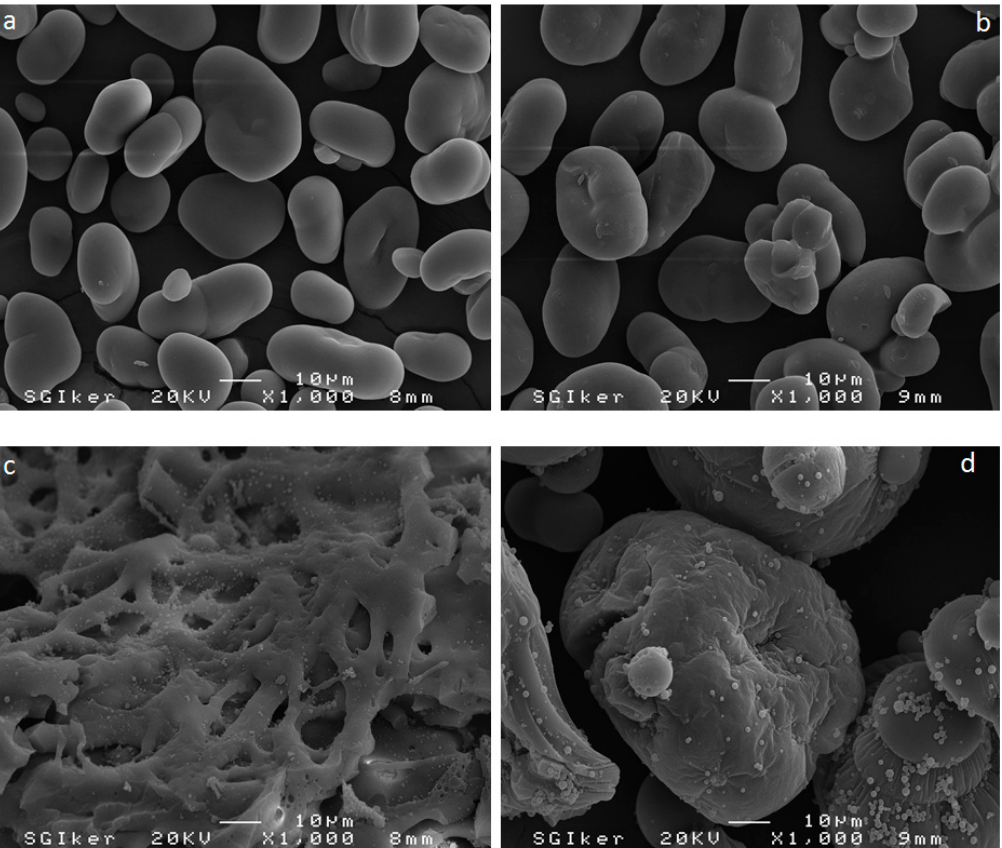
Figure 6. Scanning electron microscopy (SEM) micrographs of S-control ( a ), D-control ( b ), MS 6.1 ( c ), MD 6.1 ( d